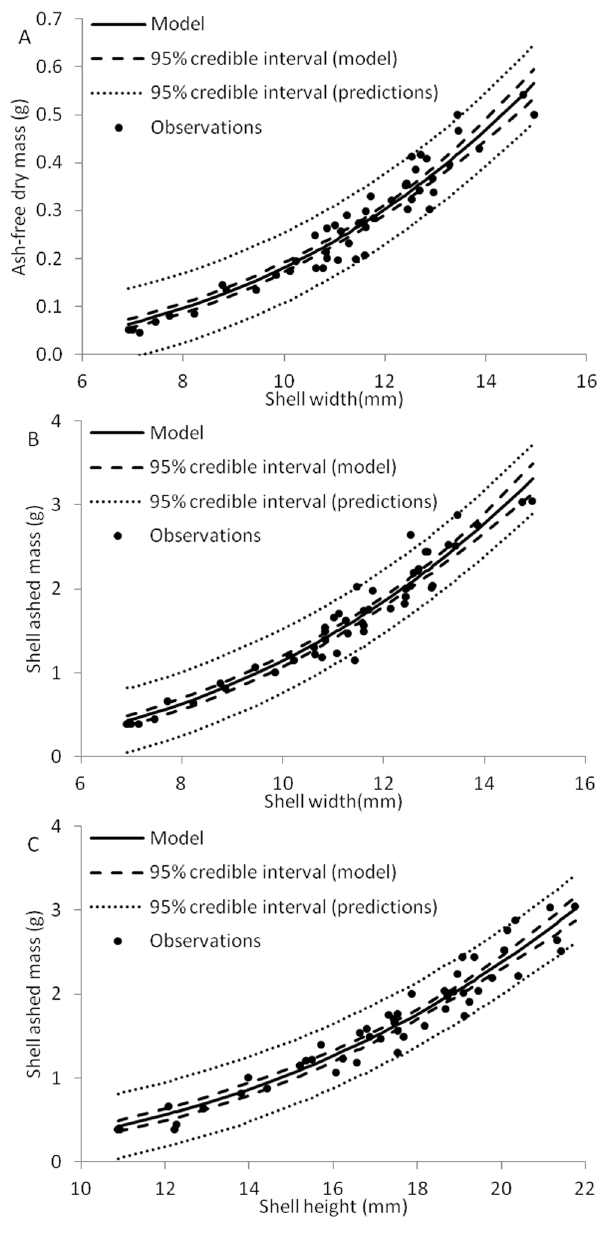
Figure 2. Models relating shell dimensions to ash-free dry mass (A) and shell ash-free dry mass (B,C) in juvenile Lampsilis siliquoidea . The model line shows the average mass for the population at a particular shell width (or height), the model 95% credible interval shows the interval for the population at that shell width, and the prediction 95% credible interval shows the range in which 95% of the mussels sampled at that width (or height) are likely to occur. Model details are in Table 3. Only strongly supported models are depicted here ( D DIC , 2.0).